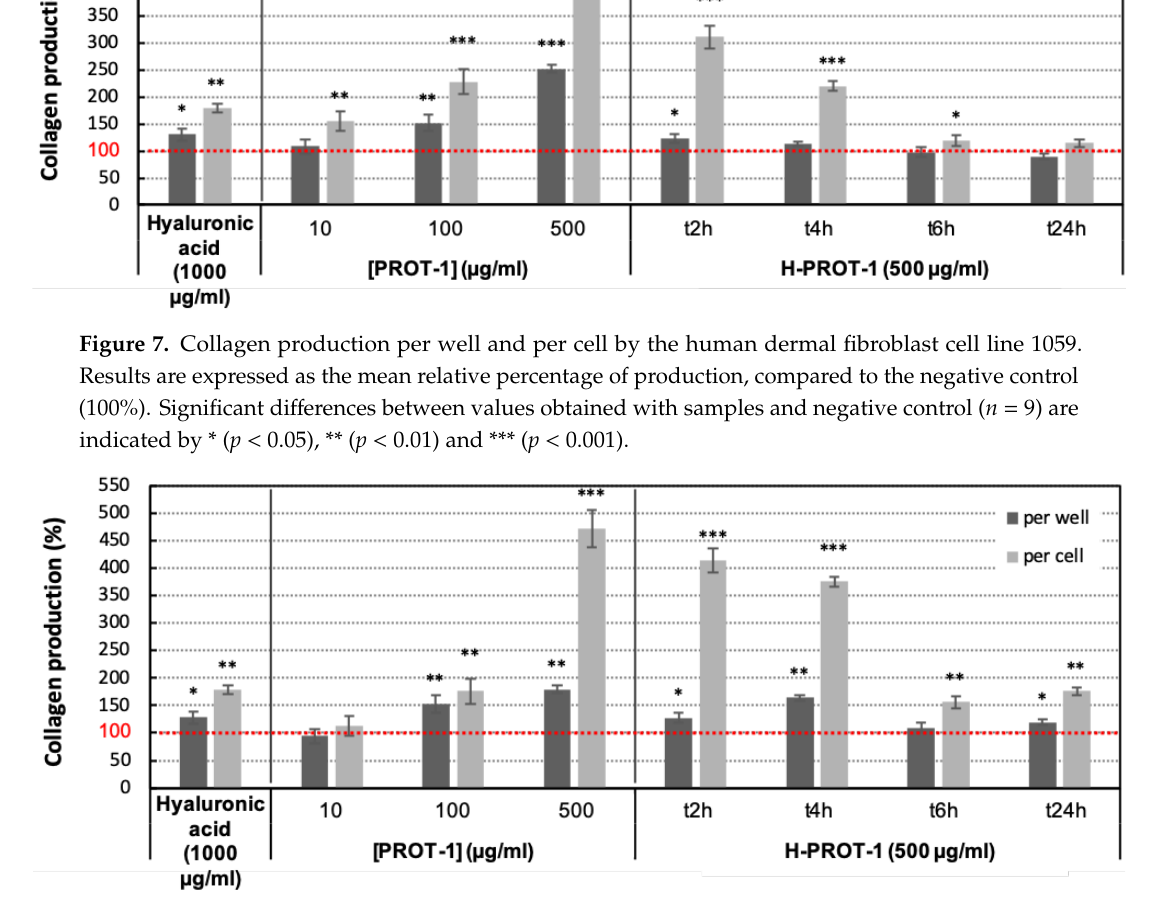
Figure 8. Collagen production per well and per cell by the human dermal fibroblast cell line 1090. Results are expressed as the mean relative percentage of production, compared to the negative control (100%). Significant differences between values obtained with samples and negative control ( n = 9) are indicated by * ( p < 0.05), ** ( p < 0.01) and *** ( p < 0.001).